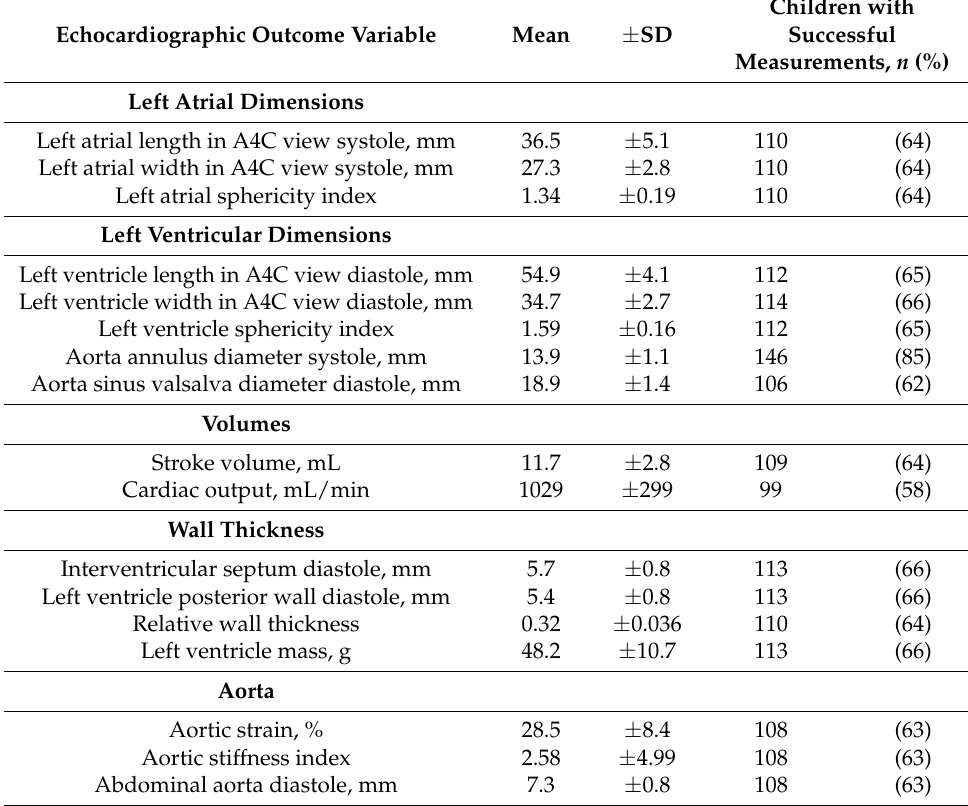
Table 2. Left heart and aortic dimensions in 6.5-year-old children born extremely preterm.